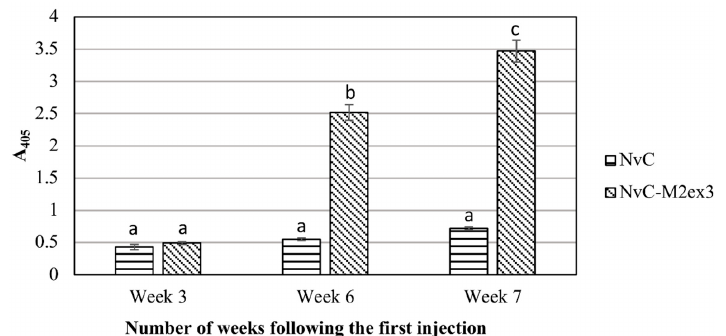
Figure 1. Immunogenicity of the chimeric protein in BALB / c mice. Serum samples of BALB / c mice immunized with NvC or NvC-M2ex3 were collected at three weeks after the primary injection, three weeks after the first booster, and one week after the second booster by submandibular bleeding. Serum samples (1:2000 dilution) from mice (n = 8) of respective groups were pooled and analyzed by enzyme-linked immunosorbent assay (ELISA). The microtiter plate wells were coated with the M2e synthetic peptide and the anti-M2e antibody reacted with the peptide was detected with the anti-mouse antibody conjugated to alkaline phosphatase. a, b, and c indicate statistical significance ( p < 0.001) of the results within each time point and when compared to other time